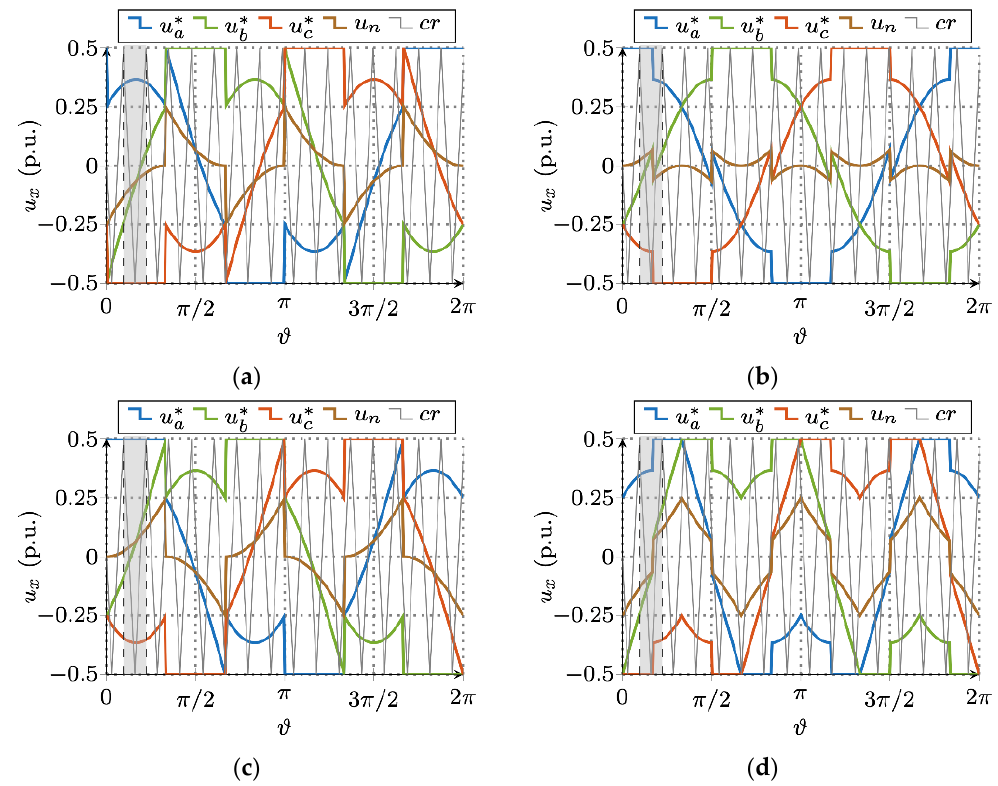
Figure 4. Phase ( u * ) and neutral ( u n ) modulating signals for: ( a ) DPWM0; ( b ) DPWM1; ( c ) DPWM2; and ( d ) DPWM3.